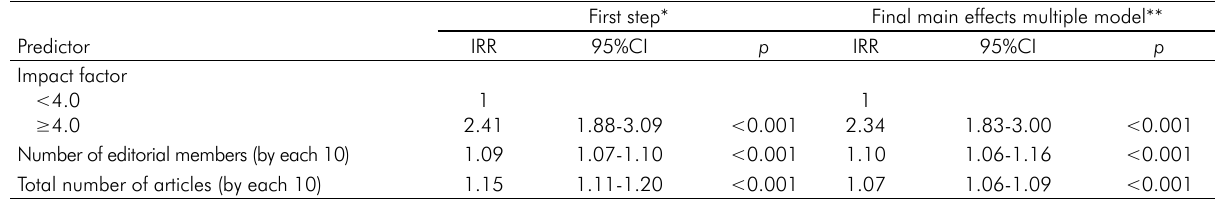
Table 2. GEE Poisson regression models for predictors of the number of articles with editorial board members as